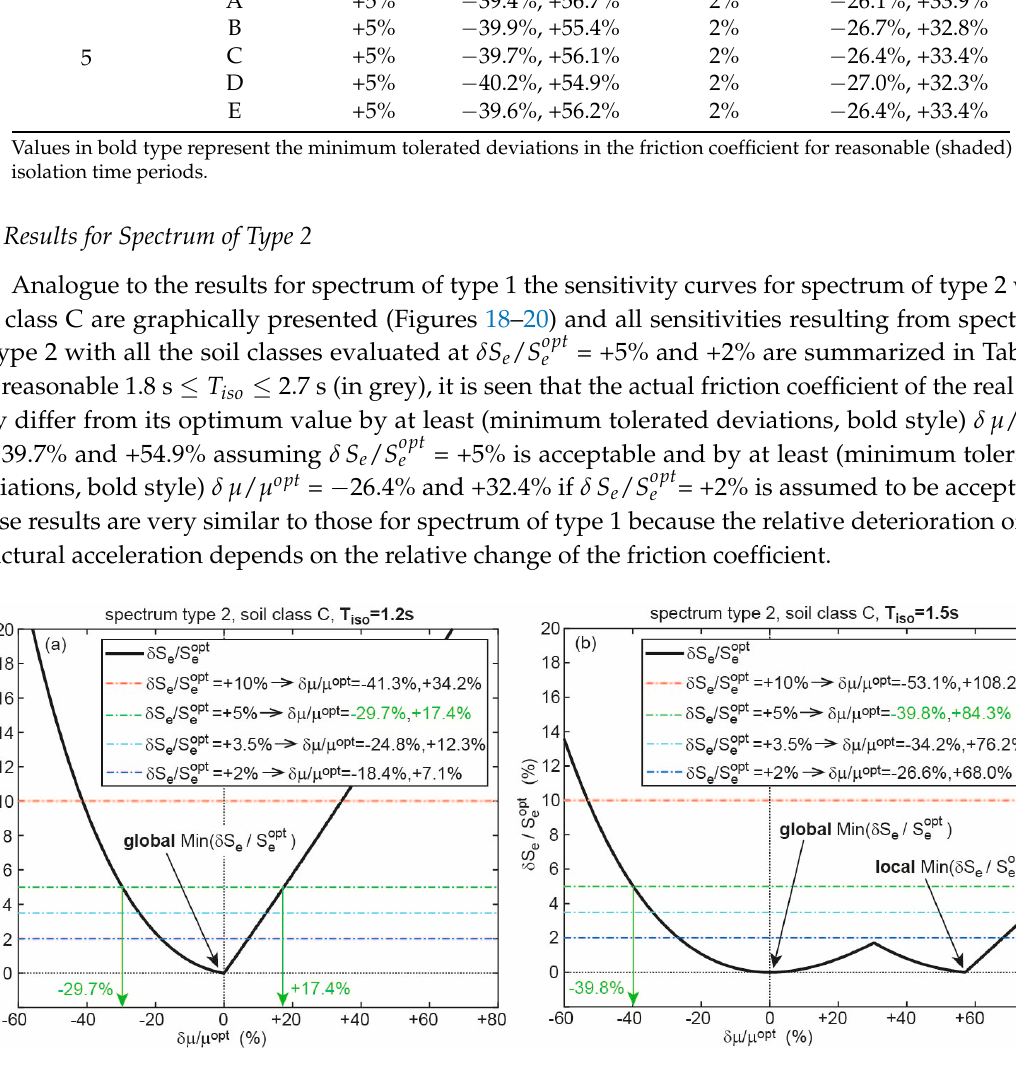
Figure 18. Sensitivity of deviation in friction coefficient from its optimum value on relative increase of structural acceleration for ( a ) T iso = 1.2 s and ( b ) T iso = 1.5 s and spectrum of type 2 with soil class C.